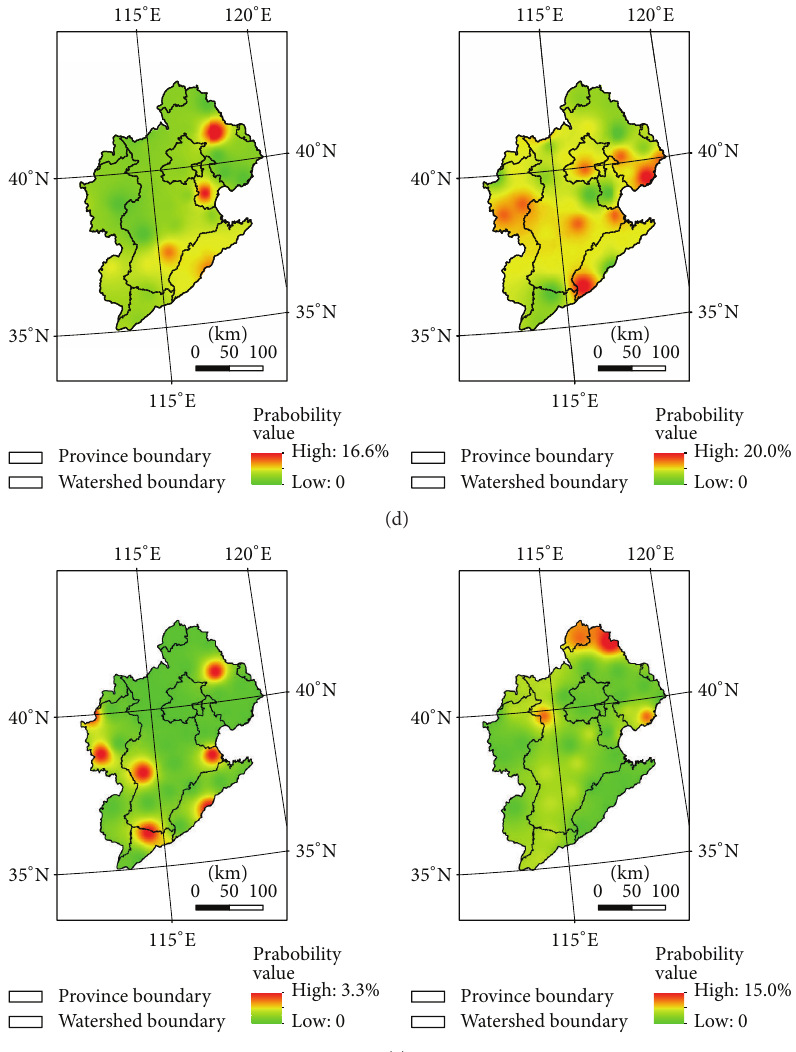
Figure 7: The comparison of spatial distribution of the occurrence probability of (a) drought, (b) light drought, (c) moderate drought, (d) severe drought, and (e) extreme drought between 1961 and 1990 (left) and between 1991 and 2010